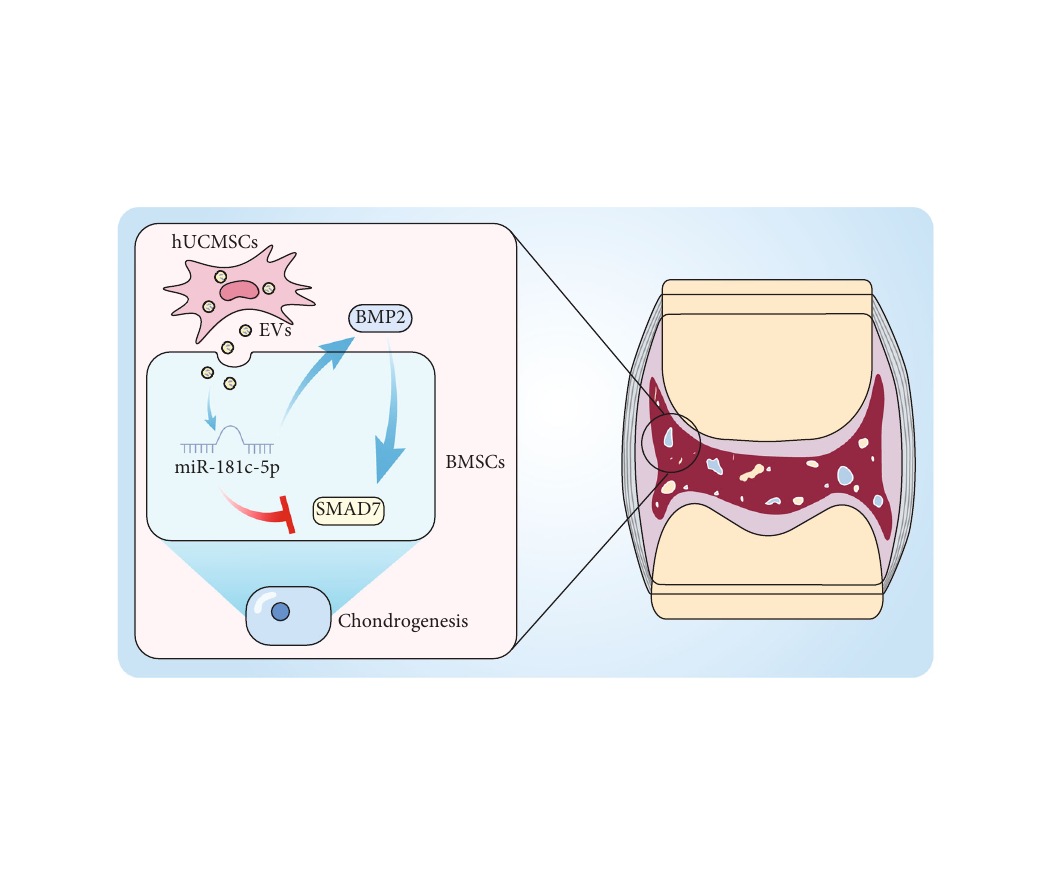
Figure 8: Molecular mechanism of hUCMSC-EVs carrying miR-181c-5p in a ff ecting repair of cartilage injury through regulating BMP2- induced SMAD7